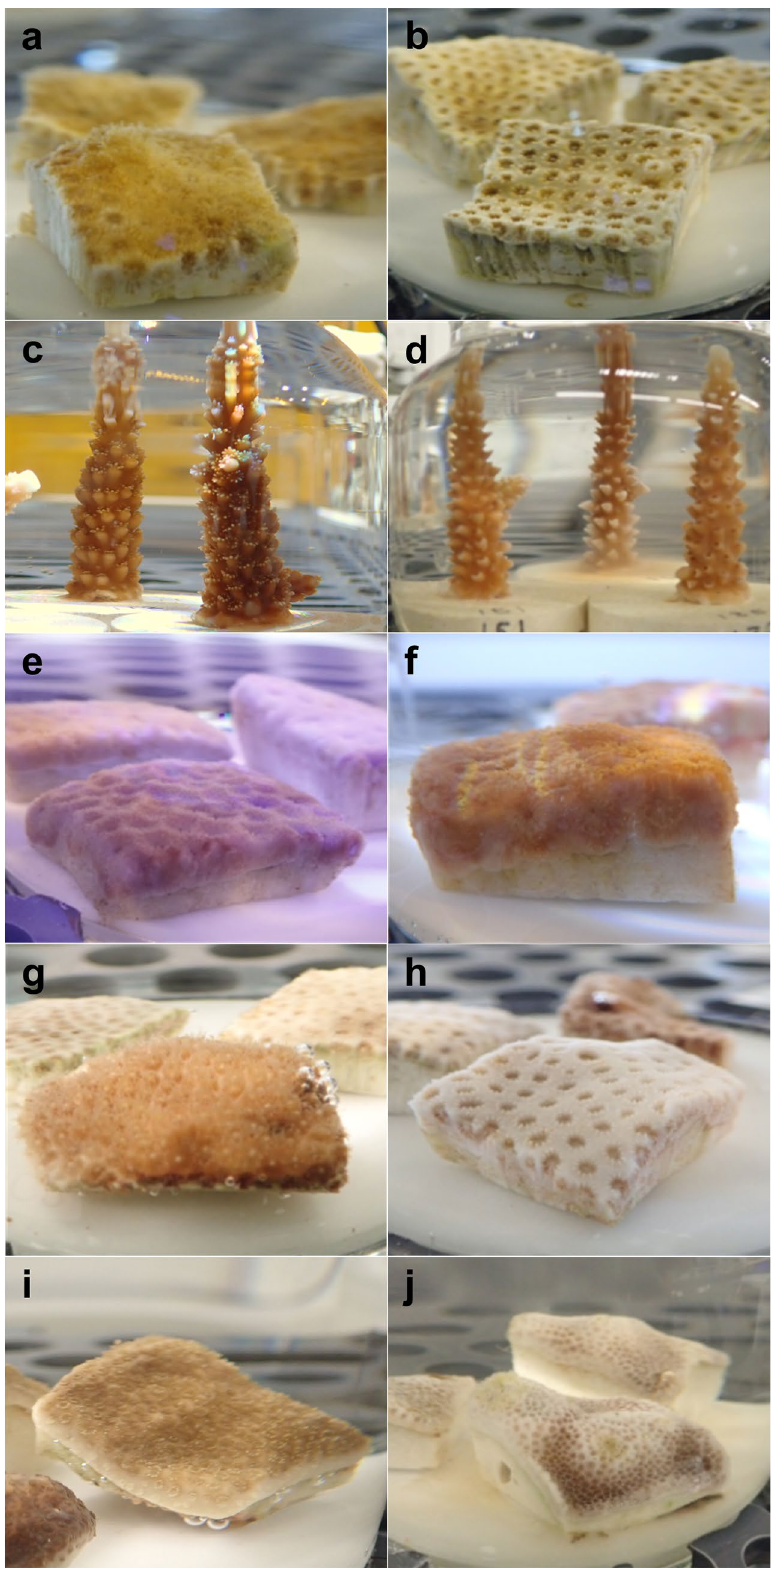
Figure 1. Typical physical changes at various time points in response to 1-methylnaphthalene (1-MN) exposure. ( a ) Solenastrea bournoni , control coral @ T1, and ( b ) polyp retraction in the 10,293 µg L −1 1-MN treatment @ T1; ( c ) Acropora cervicornis, control coral @ T12, and ( d ) elevated mucus production in the 9434 µg L −1 1-MN treatment @ T12; ( e ) Siderastrea siderea, control coral @ T8, and ( f ) tissue swelling in the 3030 µg L −1 1-MN treatment @ T8; ( g ) Stephanocoenia intersepta, control coral @ T36, and ( h ) bleaching in the 1616 µg L −1 1-MN treatment @ T36; and ( i ) Porites astreoides , control coral @ T36, and ( j ) tissue loss/mortality in the 12,530 µg L −1 1-MN treatment @